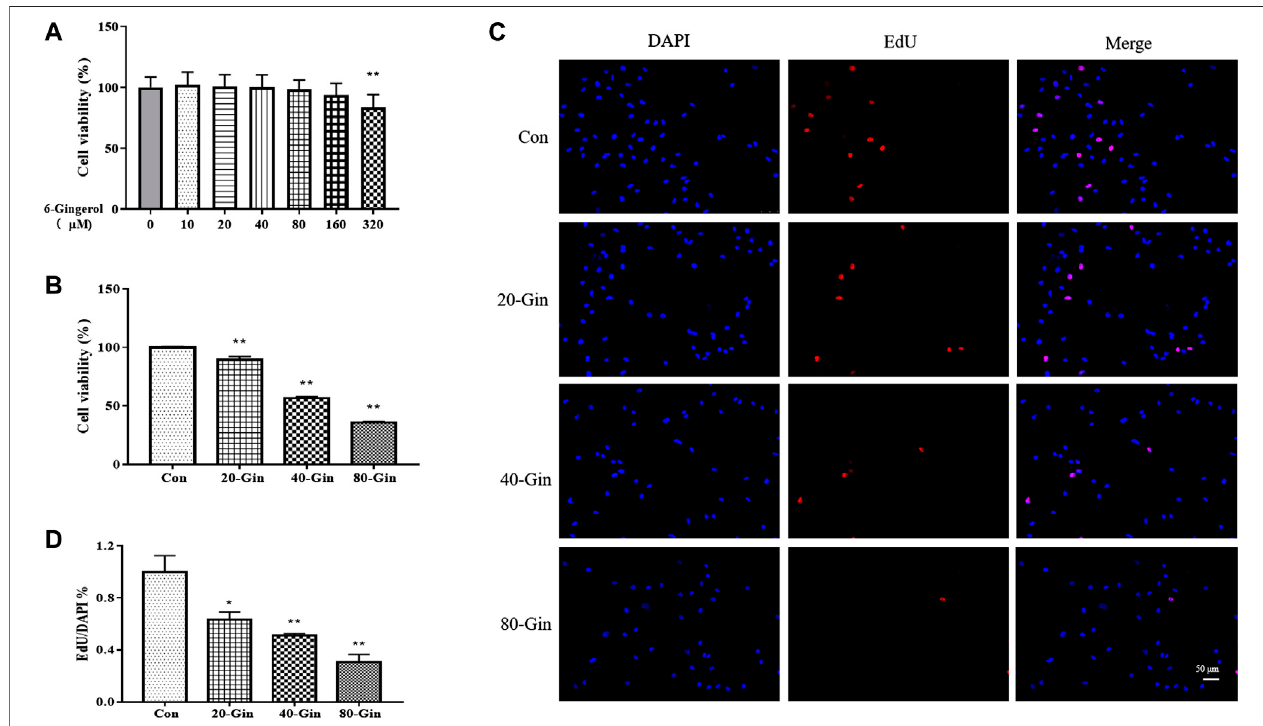
FIGURE 3| 6-Gingerol inhibits the growth of A549cells. (A) The viability ofCCD19-Lu cells with 6-Gingerolat different concentrations (0 – 320 μ M); (B) The viability ofA549cellswith6-Gingerolat differentconcentrations; (C) Therepresentative imagesofEdU andDAPI; (D)